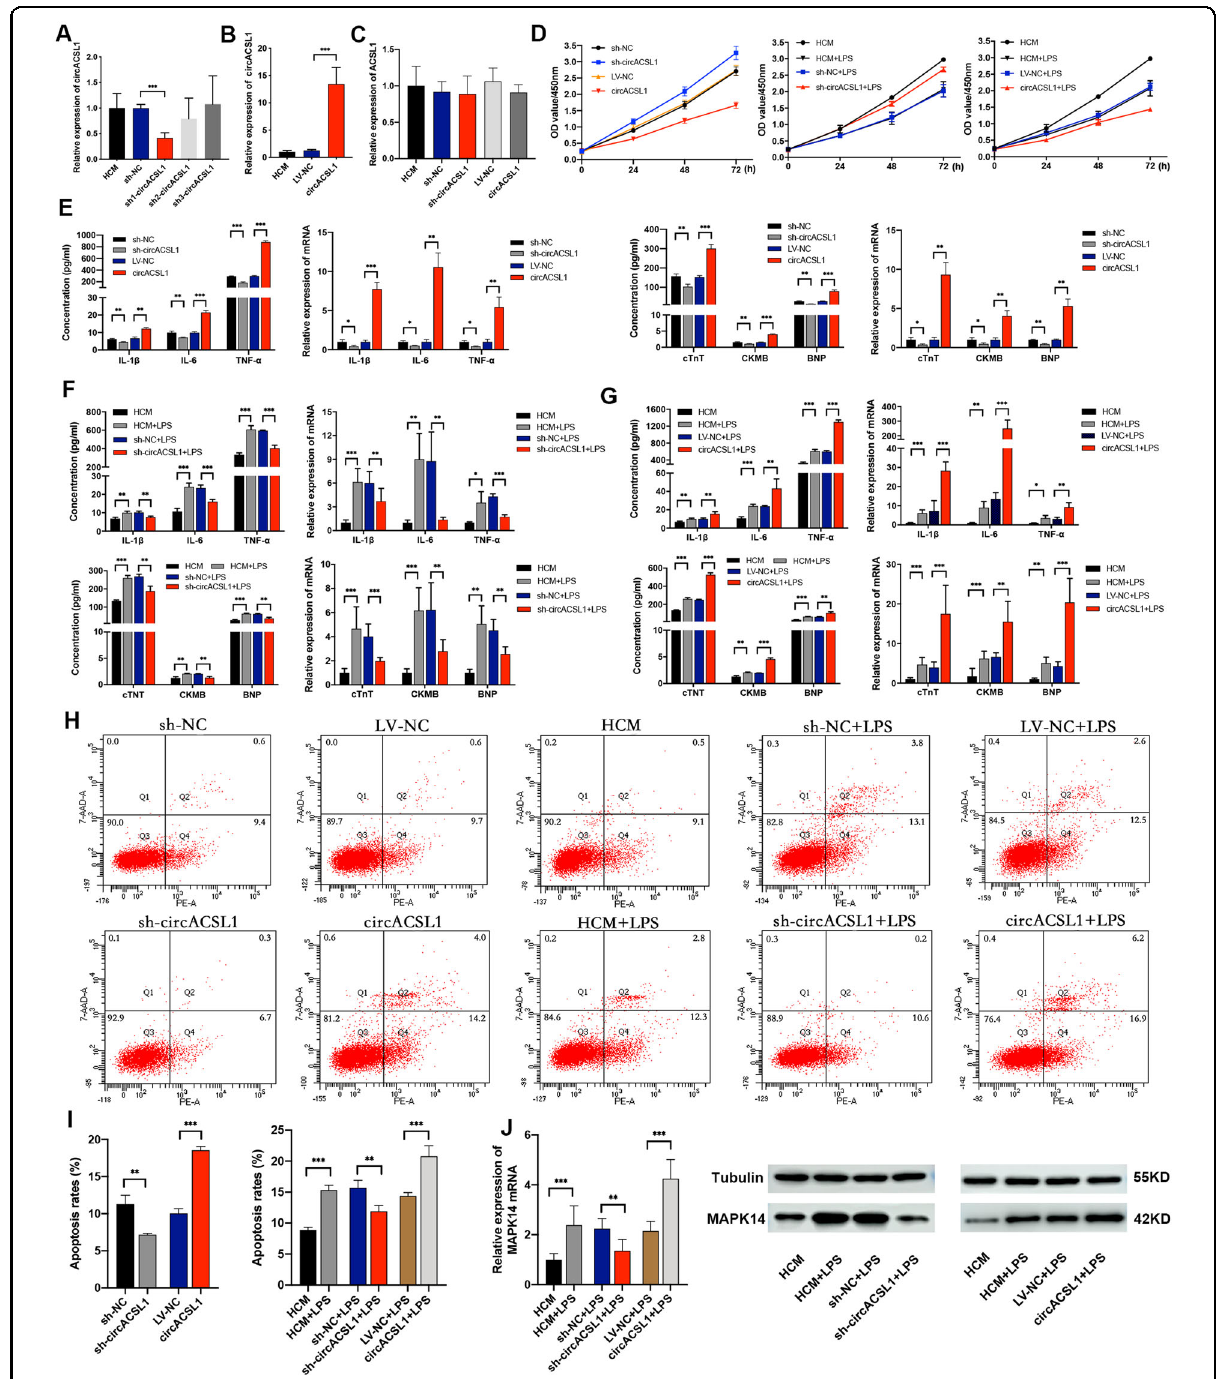
Fig. 3 CircACSL1 aggravates in fl ammation, myocardial injury, and apoptosis in HCM. A , B The ef fi ciency of knockdown or overexpression of circACSL1 in HCM cells was detected by qRT-PCR. C The mRNA level of ACSL1 pre-mRNA in HCM transfected with circACSL1 overexpression vector or sh-circACSL1 showed no signi fi cant differences compared with their corresponding negative controls. D After transfection with sh-circACSL1 or circACSL1 overexpression vector, growth curves of HCM with or without LPS stimulation were measured by the CCK-8 assay. E , G ELISA and qRT-PCR assay showed the expression levels of IL-1 β , IL-6, TNF- α , cTnT, CKMB, and BNP in HCM with circACSL1 knockdown or overexpression. E , cells without LPS stimulation; F , G , cells with LPS stimulation. H , I Cell apoptosis was measured with annexin V-FITC/7AAD double staining using fl ow cytometry assay. J The mRNA level and protein level of MAPK14 in HCM with circACSL1 knockdown or overexpression were detected by qRT-PCR and WB, respectively. Data are presented as mean ±SD ( n = 3 biologically independent samples). * p < 0.05; ** p < 0.01; *** p < 0.001 (Student ’ s t